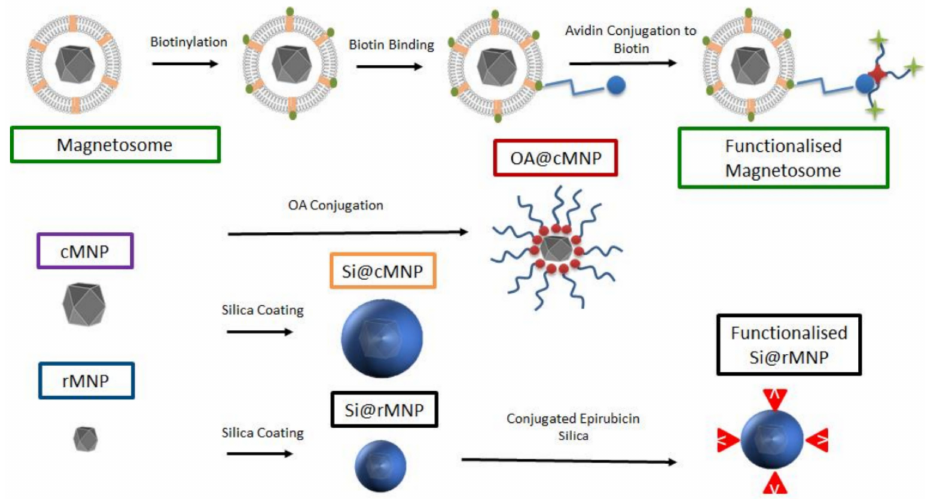
Figure 19. A schematic of the experimental design and samples produced. The top labeled in green depicts the magnetosome and how it is biotinylated for functionalization. Center-left shows the control cMNP labeled in purple with surface coatings of oleic acid (red) and silica (orange label). The bottom-left shows smaller control rMNP (blue label) coated with silica (black label) and with conjugated epirubincin (bottom right). Sample color-code used throughout in figures. Reprinted from [239], license CC BY